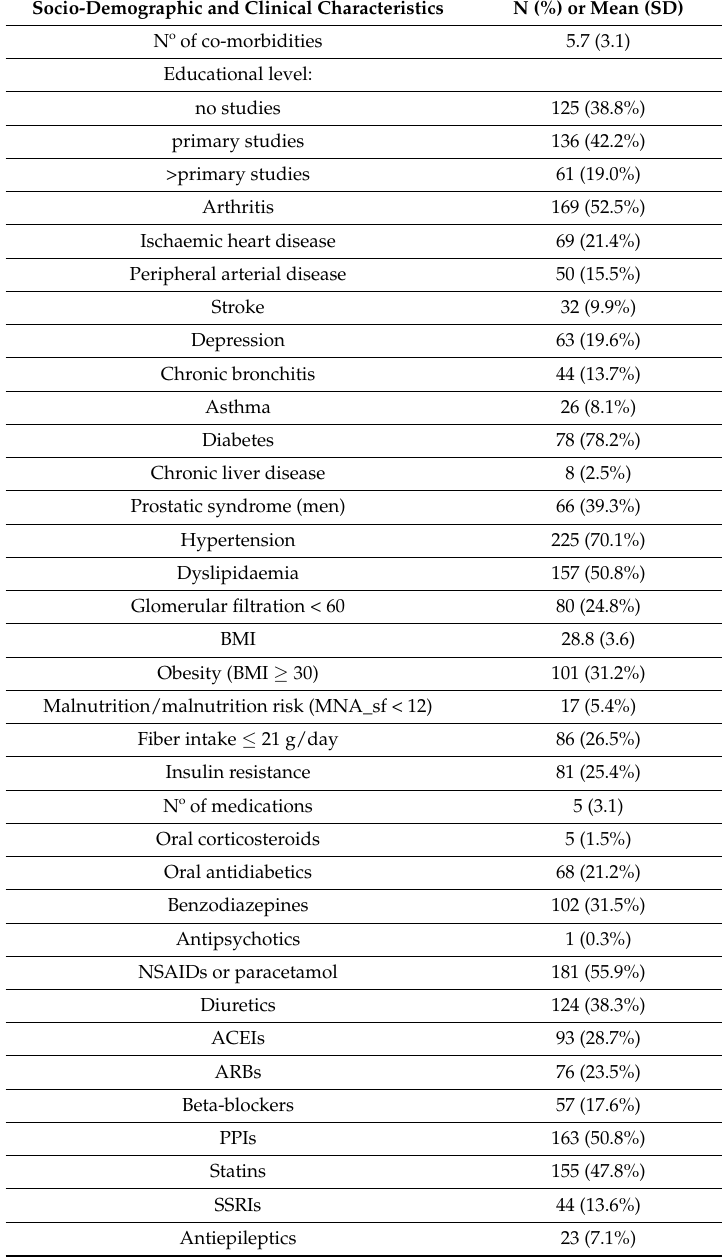
Table 1. Description of co-morbidities and medication use in the study